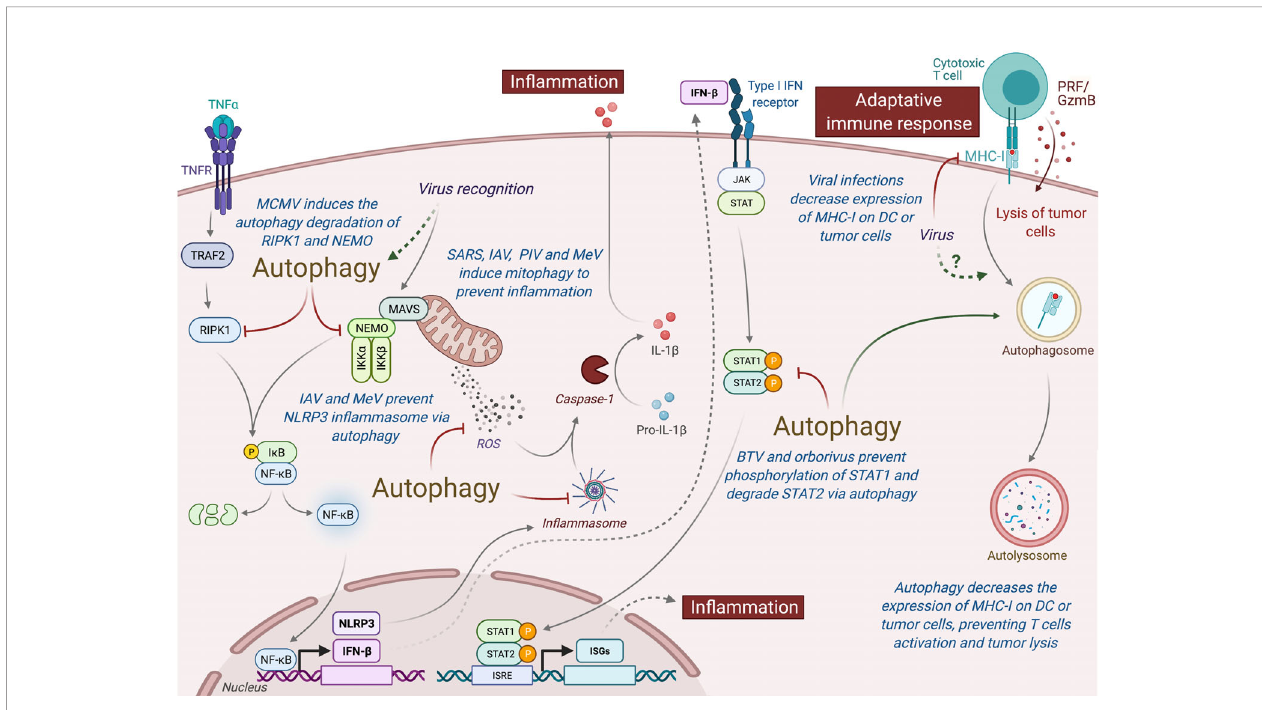
FIGURE 5 | Autophagy induced under viral infection can perturb antitumor immunity. Autophagy can interfere with innate and adaptive immunity and impact the antitumor immune responses. Viruses-induced autophagy perturbs type I IFN pathway by limiting NF- k B activation and STAT1/STAT2 phosphorylation. Several viruses (e.g., SARS, IAV, PIV, and MeV) can also modulate mitochondria activity via mitophagy and prevent in fl ammation by inhibiting the release of ROS or by preventing the formation of in fl ammasome. Viral infections or autophagy can also modulate the expression MHC-I by tumor cells or DC, limiting the action of antitumor cytotoxic T cells. MCMC, Murine Cytomegalovirus; IAV, In fl uenza A Virus; MeV, Measles Virus; SARS, SARS-Coronavirus; PIV, Parain fl uenza Virus; BTV, Bluetongue virus; MHC-I, Major Histocompatibility Complex I; PRF/GzmB, Perforin/Granzyme B, DC, dendritic